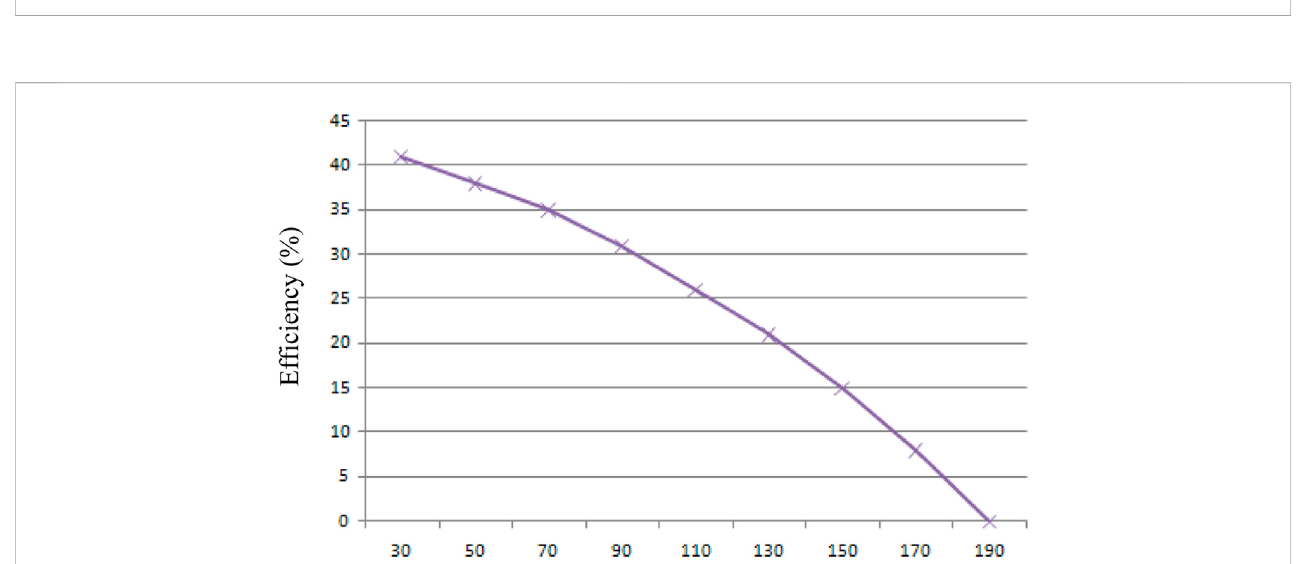
Ef fi ciency vs. the receiver surface temperature for a .031-m receiver tube.